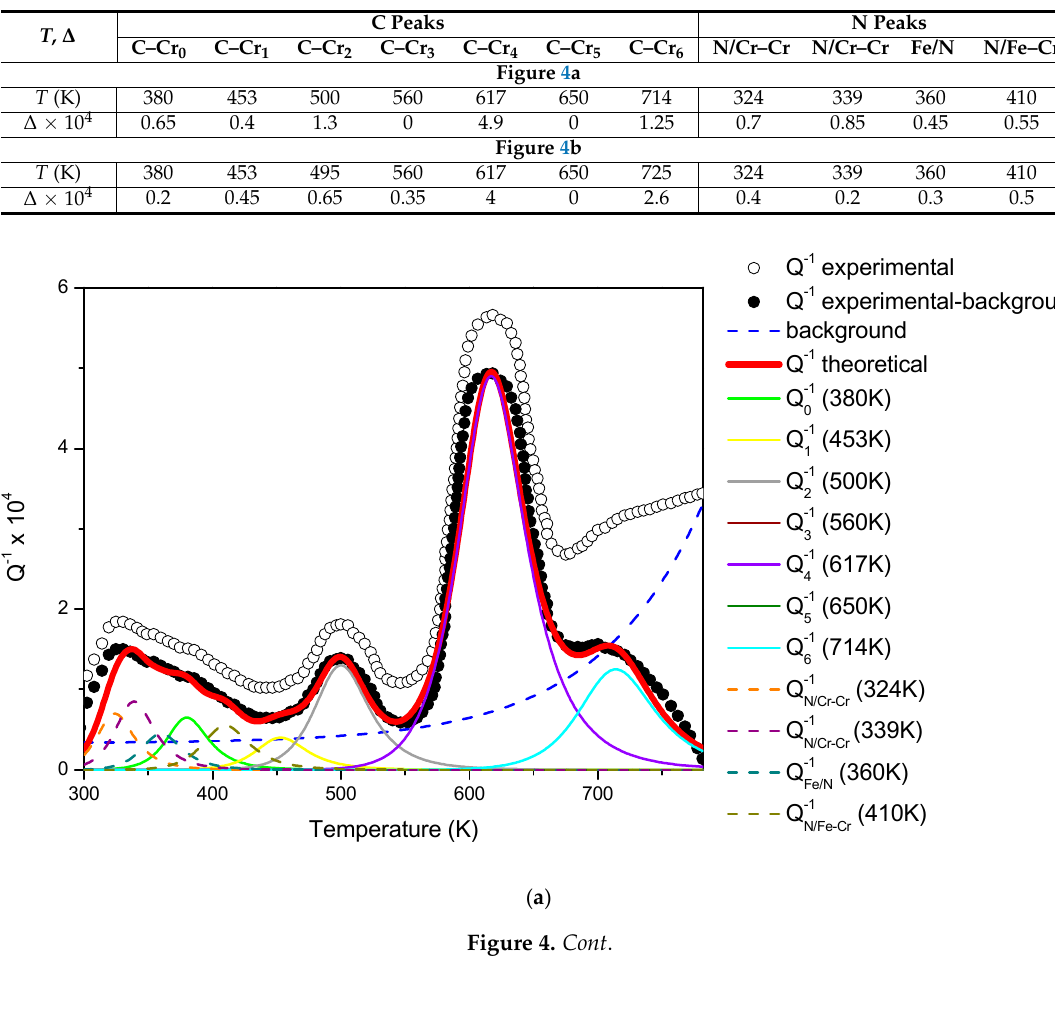
Table 3. Peak positions ( T ) and relaxation strengths ( ∆ ) used to fit experimental data in Figure 4.